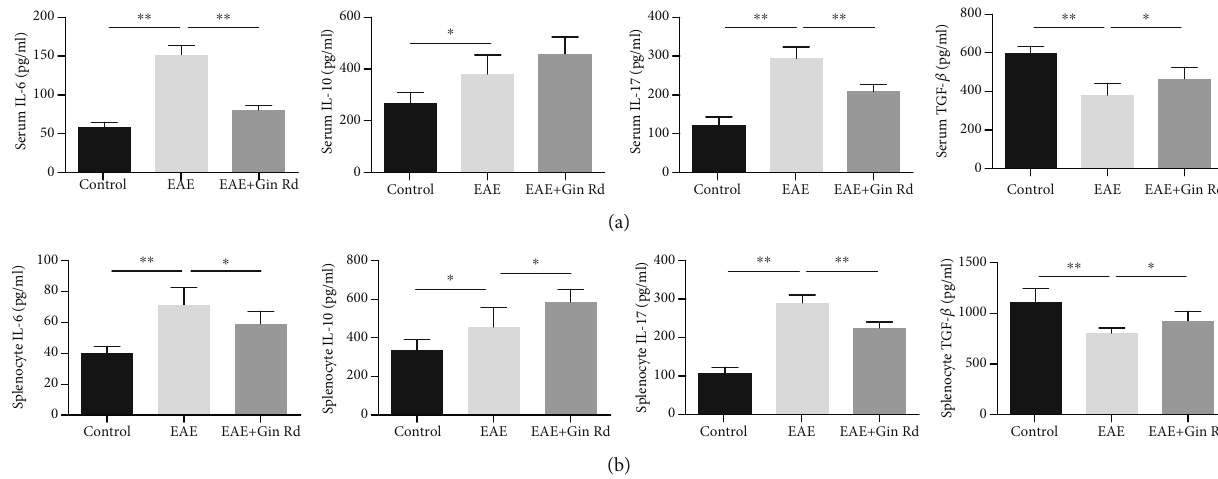
Figure 3: The concentrations of IL-6, IL-10, IL-17, and TGF- β in serum and splenocyte supernatants of mice ( n = 6 ). Following immunization and treatment with Ginsenoside Rd, some mice from the control, EAE, and Ginsenoside Rd-treated EAE groups were sacri fi ced at day 20 postimmunization. Serum was collected, and splenocytes were isolated, for ELISA assay to detect the concentrations of IL-6, IL-10, IL-17, and TGF- β . Data are expressed as mean ± SD for each group ( n = 3 ). (a) ELISA analysis for the levels of IL-6, IL-10, IL- 17, and TGF- β in serum of mice. (b) ELISA analysis for the levels of IL-6, IL-10, IL-17, and TGF- β in splenocyte supernatants of mice. ∗ P < 0 : 05 , ∗∗ P < 0 : 01 vs. EAE group. Gin Rd: Ginsenoside